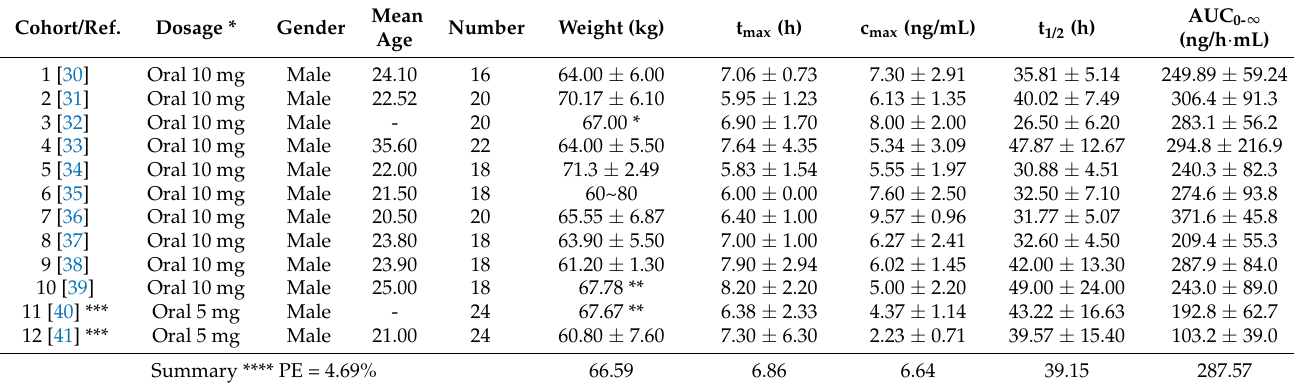
Table 2. Clinical pharmacokinetic data of amlodipine in Chinese male